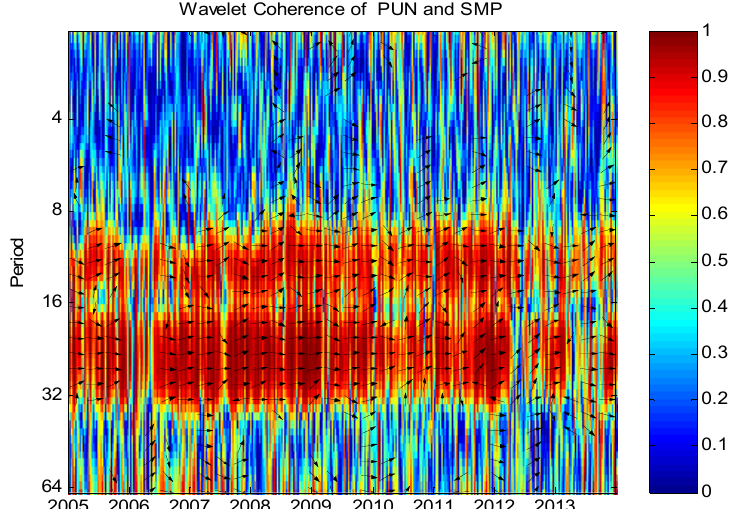
Figure 12. Wavelet coherence of hourly price PUN and SMP DA. The horizontal axis shows time, while the vertical axis shows the scale or period in hours. The warmer the colour of a region, the higher the degree of dependence or coherence between the two